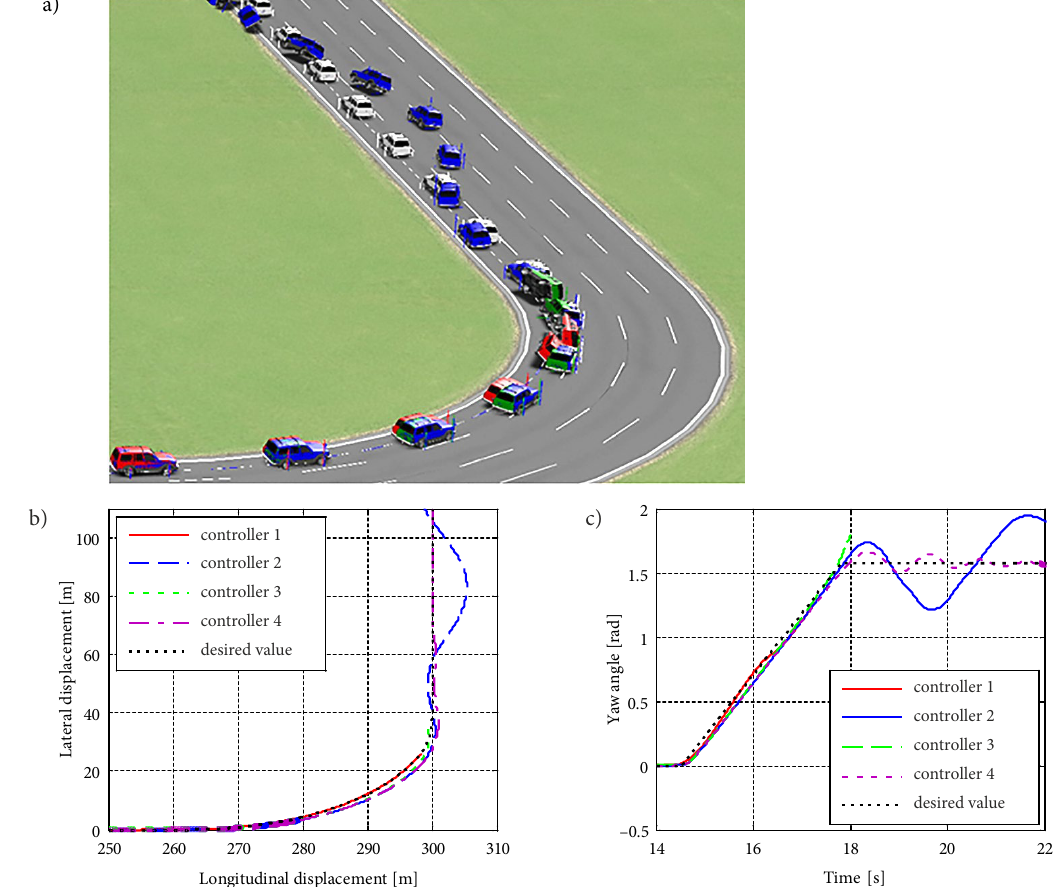
Figure 9. Simulation results in the anti-rollover simulation: a – animation effect; b – lateral displacement; c –